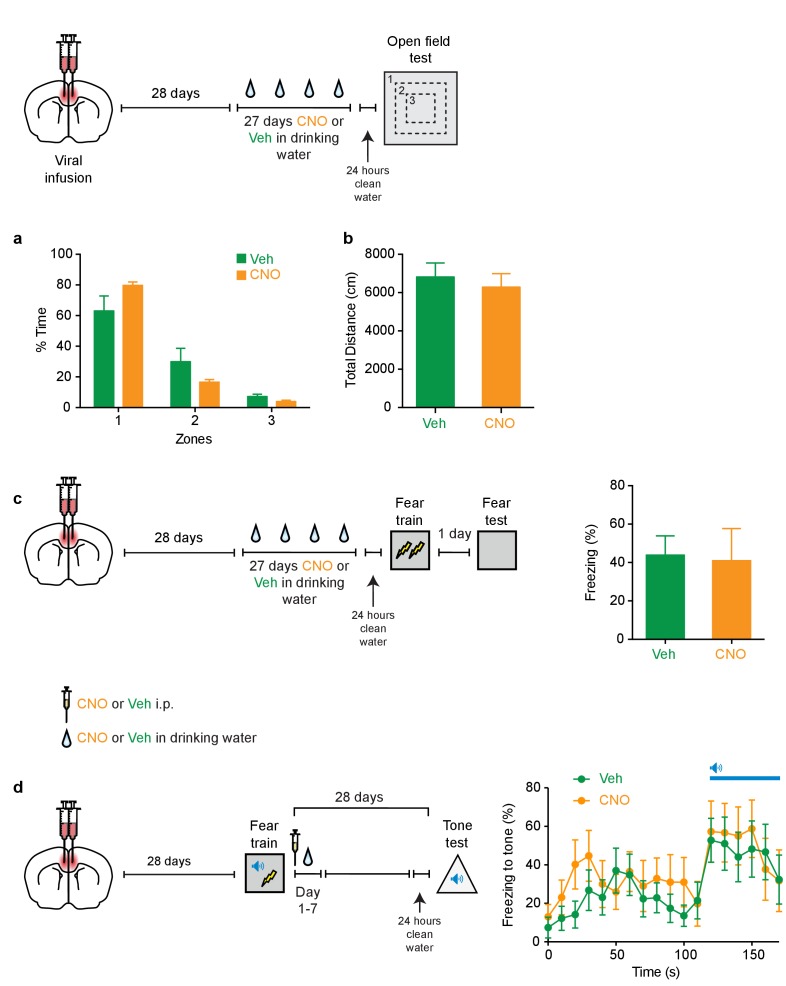
Chronic inhibition of PV+cells does not alter anxiety level or locomotion, or alter subsequent learning or retrieval, or affect post-shock sensitivity to pain.During an open field test, mice infused with virus in ACC and treated with Veh or CNO did not show differences in (a) time spent in different zones (outer, Zone 1; middle, Zone 2; or inner, Zone 3; Veh n = 8, CNO n = 10; Friedman test zones p<0.0001; Mann-Whitney test, zone 1 Veh versus CNO p=0.083, zone 2 Veh versus CNO p=0.17, zone 2 Veh versus CNO p=0.083), or (b) total distance (cm) traveled (t-test t16 = 0.54, p=0.60). (c) No disruption in freezing during fear memory test (1 d following training) in mice micro-infused with hM4Di-mCherry virus in ACC and treated with CNO versus Veh prior to fear conditioning (drug delivery (CNO or Veh) in water for 27 days and 1 d clean-water washout) (Veh n = 10, CNO n = 4, t-test t12 = 0.15, p=0.88). (d) To assess the effect of CNO treatment on tone fear memory, mice infused with the AAV-DIO-hM4Di virus in ACC were trained in tone fear conditioning. Increased freezing to tone during test on day 28 in both CNO- or Veh-treated groups (i.p. systemic injection post-training followed by drug delivery (CNO or Veh) in water for days 1–7) (30 s pre-tone-onset freezing versus 30 s post-tone-onset freezing; DMSO n = 8, CNO n = 7; two-way repeated measures ANOVA pre-tone-onset versus post-tone-onset x Veh versus CNO; pre-tone-onset versus post-tone-onset F1,13 = 16.8, p=0.001; Veh versus CNO F1,13 = 0.38, p=0.55; interaction F1,13 = 0.03, p=0.86). Data are mean ±s.e.m.